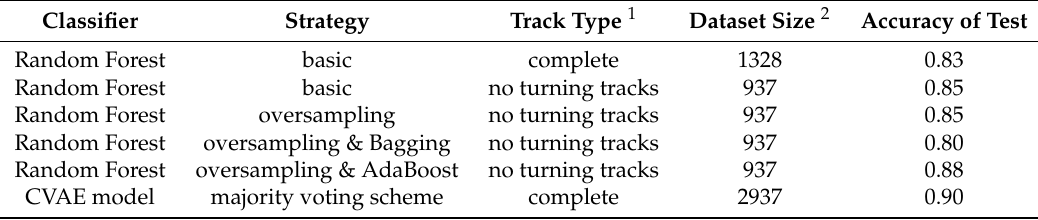
Table 3. Evaluation results for the random forest model with different boosting strategies and the CVAE model.